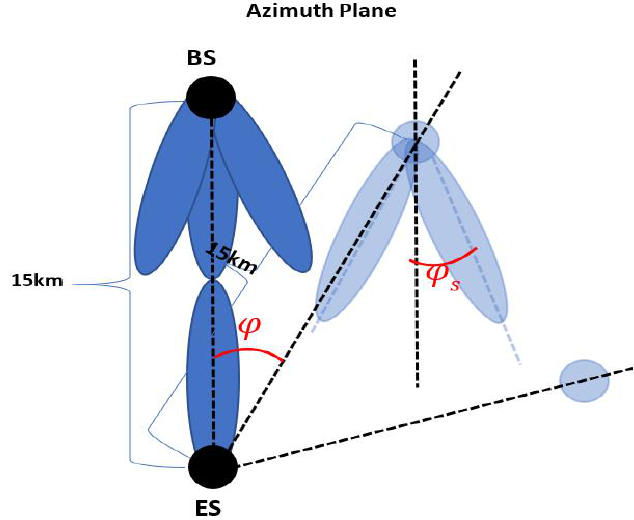
Figure 8. BS-ES relative angle change.